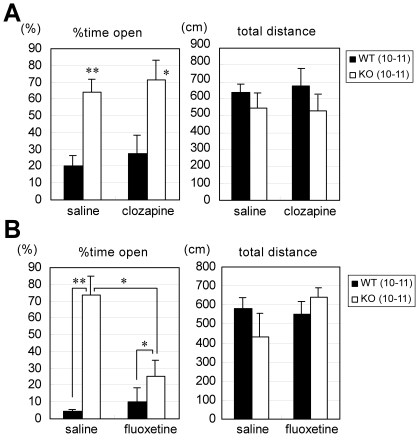
Effects of clozapine or fluoxetine administration on Lrrtm1 KO behavior in the elevated plus maze test.(A, B) Percentage of time spent in the open arms and total distance traveled in the elevated plus maze test. WT and KO mice were subjected to the test 30 min after intraperitoneal injection of saline, 0.4 mg/kg clozapine, or 10 mg/kg fluoxetine. (A) clozapine treatment. (B) fluoxetine treatment. Values are presented as means ±SEM. * P<0.05; ** P<0.01 in U-test.